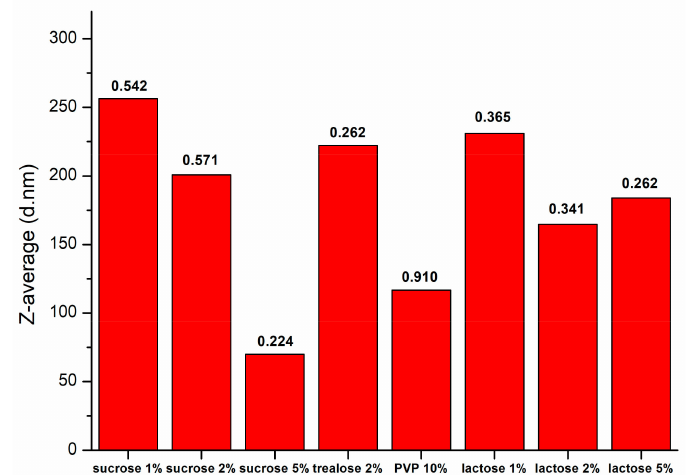
Figure 2. Mean size and PDI values of PLGA-CDs1% NPs with di ff erent cryoprotectant after